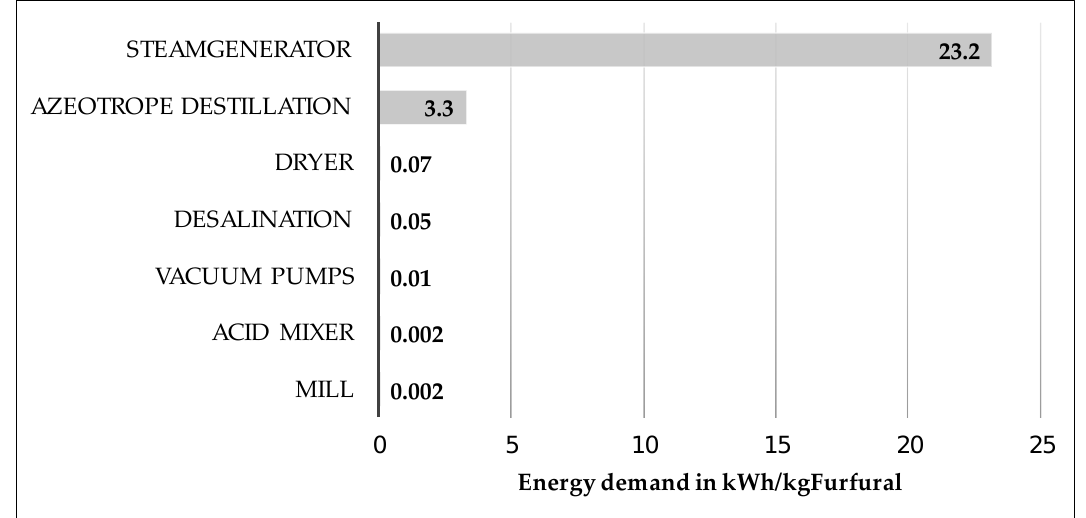
Figure 6. Energy intensity in the synthesis of furfural (when using the Huaxia Furfural technology modified by Westpro).